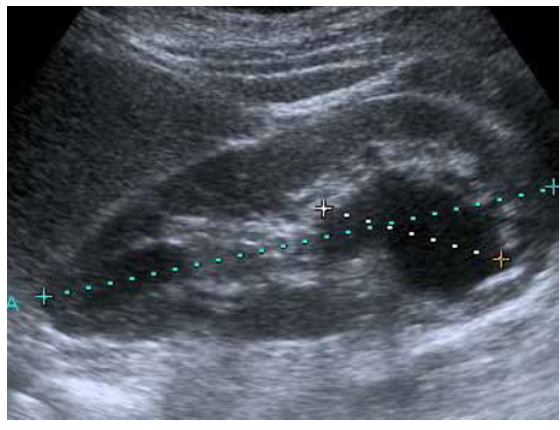
Figure 1. Ultrasonography of the left kidney showing anechoic le- sion in the lower pole obtained with a 3.5-MHz